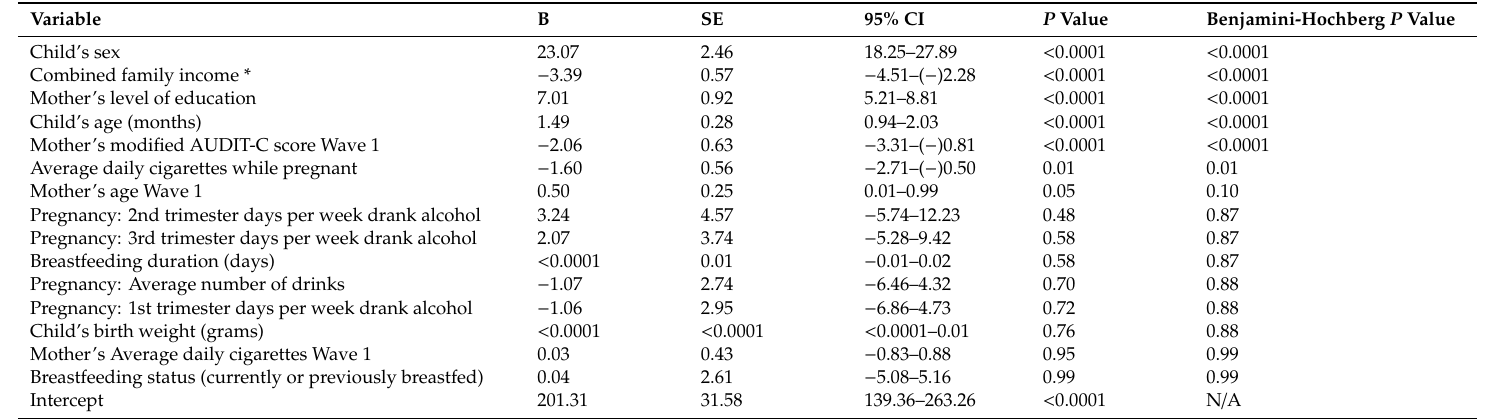
Table 4. Grade 3 NAPLAN spelling scores (babies who had been breastfed at any